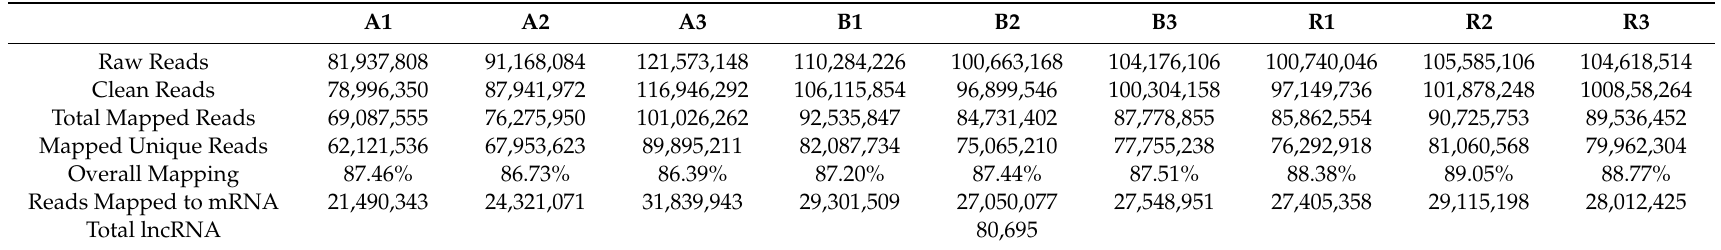
Table 1. Summary of the data of transcriptome in A, B, and R